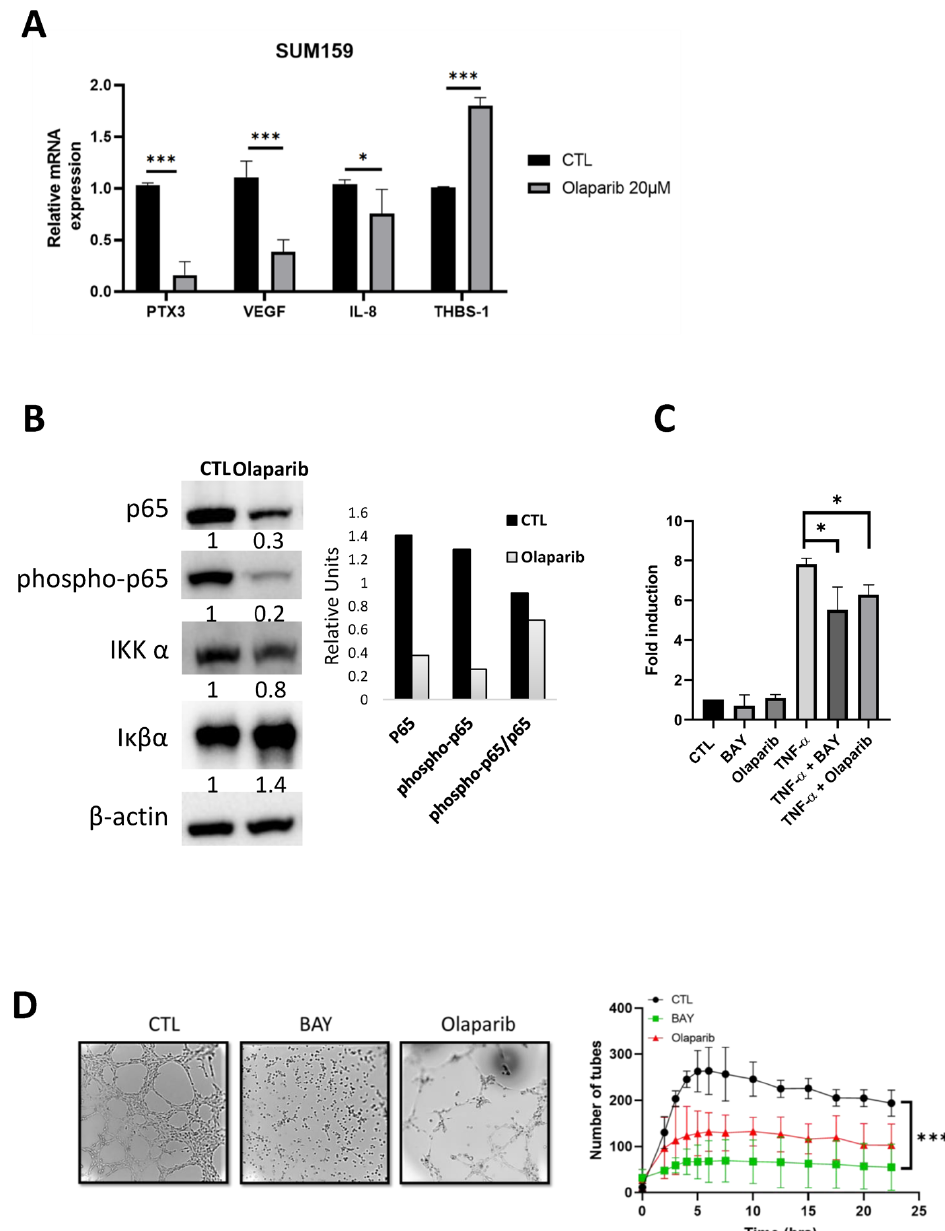
Figure 4. VM is regulated by PARPis through the NF- κ B signaling. ( A ) RNA was isolated from the SUM159 cells and the gene expression was analyzed by the qRT-PCR. The results represent the relative transcript levels and are expressed as mean ± SEM from three independent experiments. ( B ) Western blot analysis of NF- κ B p65 and the phospho-p65 protein, IKK α , and I κ B α in the SUM159 cellular extracts, treated or not, with 20 µM olaparib for 90 min. Ratio of phospho-p65/p65 are shown as histograms after the quantification and normalization with β -actin. ( C ) SUM159 cells were trans- fected with plasmids encoding a NF- κB luciferase reporter gene and a plasmid encoding β -galacto- sidase. Cells were pre-treated for 5 h with the NF- κB inhibitor BAY -11-7082 (2.5 µM) or with